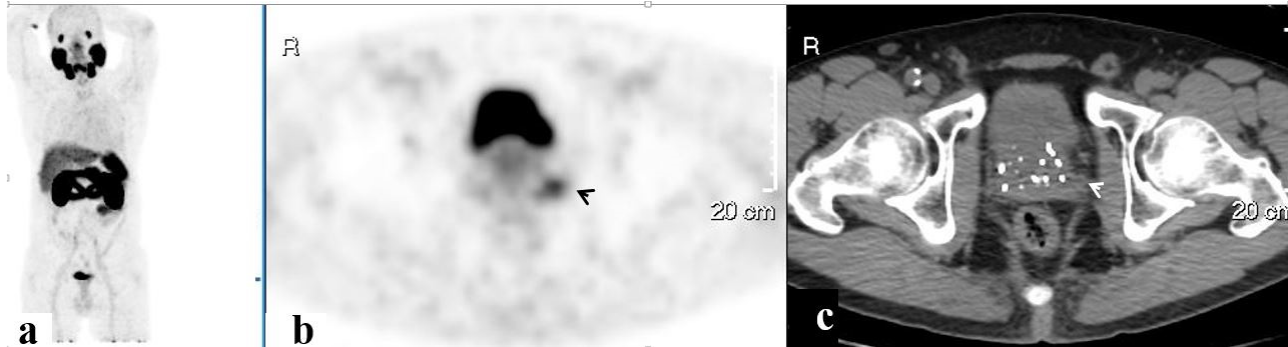
Figure 2. A PSMA-avid lesion in the seminal vesicles. 68Ga-PSMA scan, PET ( a ) and CT ( b ) axial slices demonstrating focally increased uptake in the seminal vesicles on the right (arrows).